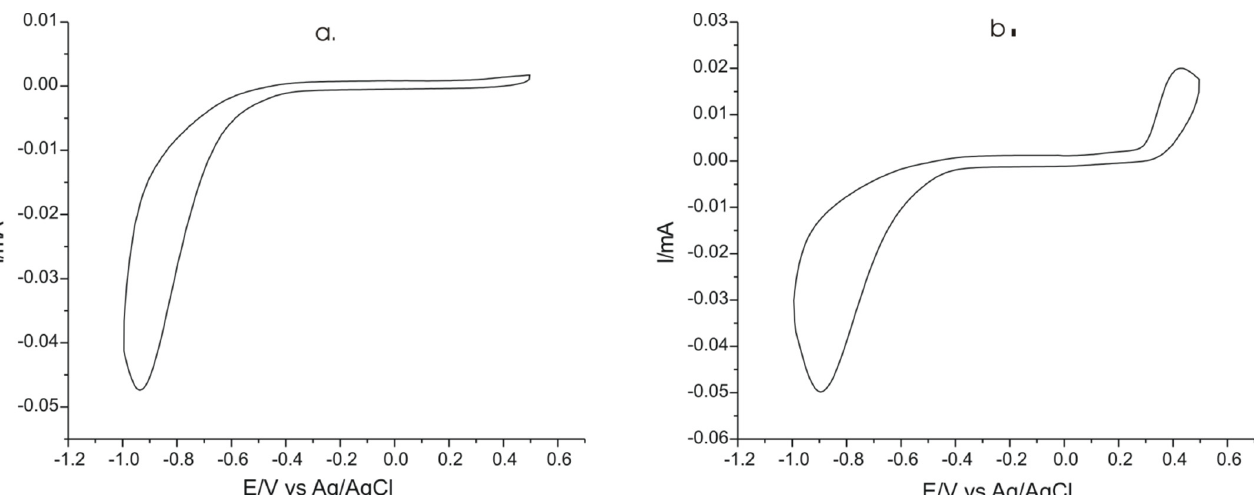
Figure 6. Electrochemical response of carbon screen-printed electrode immersed in: ( a ) 0.1 M KCl and ( b ) 0.1 M KCl and 10 − 3 M L-Tyr solution at 0.1 V × s − 1 .